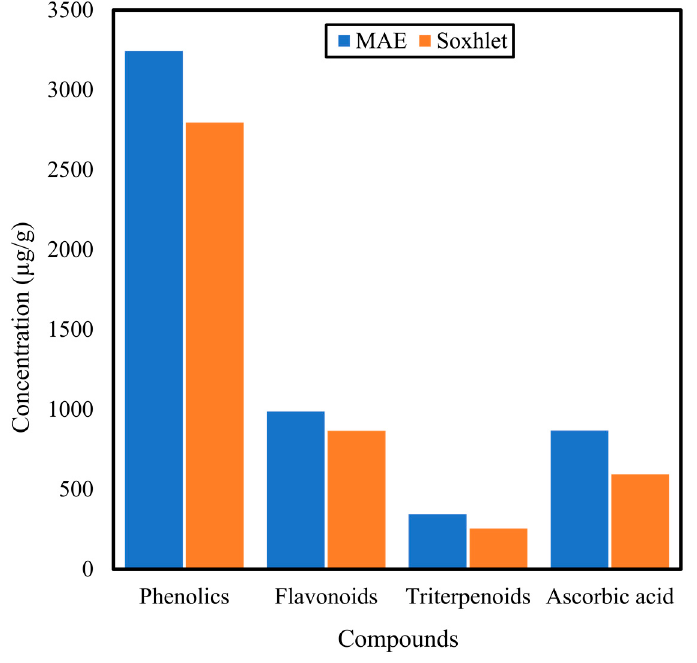
Figure 6. Difference of compound concentrations extracted from Centella asiatica using microwave and Soxhlet extraction methods by Sen et al. [54].